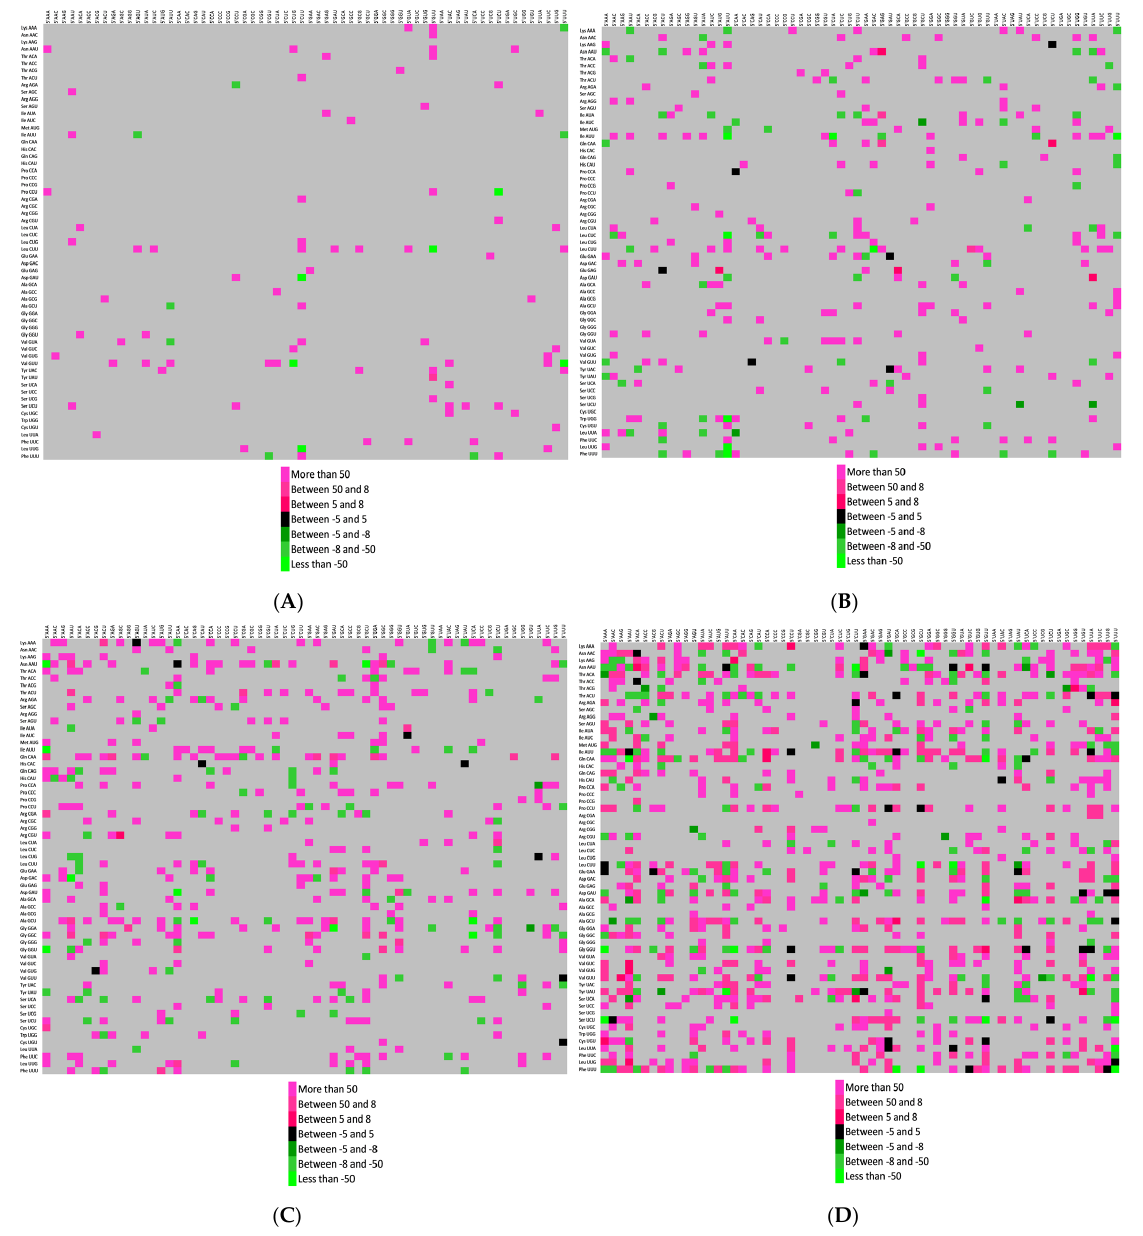
Figure 3. Codon context analysis for the ( A ) E gene, ( B ) M gene, ( C ) NP gene, and ( D ) S gene. The two-color scale shows the codon context bias. Strongly preferred codon context bias is depicted as pink, while strongly rejected codon context is depicted as green. In the case where the 3 ′ context is not strongly biased, it is depicted as black. The Grey color shows the presence of no context. The color scale is given in the figures.